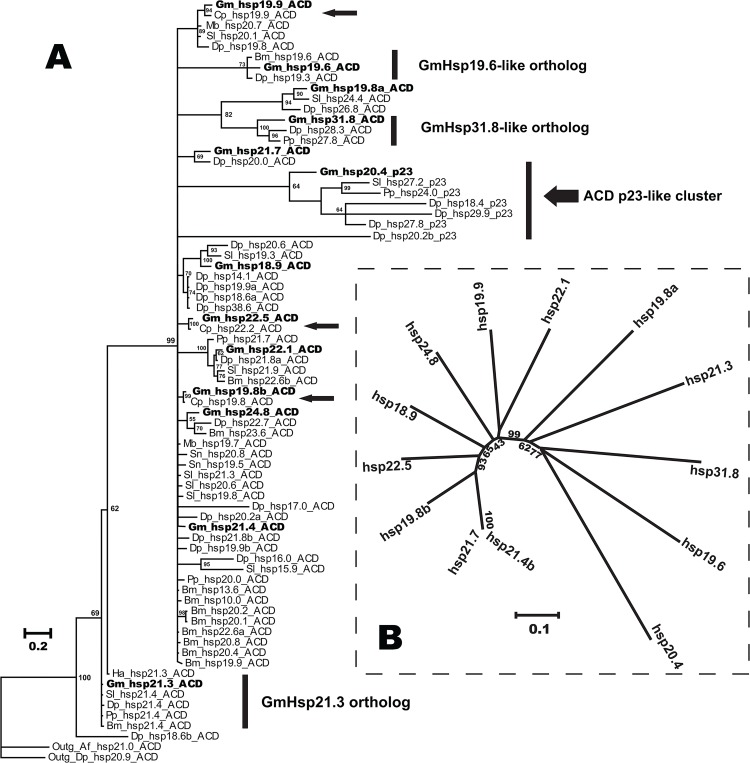
Phylogenetic trees of OFM sHsps.A. Phylogenetic tree of the lepidopteran sHsps. A total of 71 lepidopteran sHsps and two outgroup sequences were used in this Bayesian phylogenetic tree. Only the conserved a-crystalline domains were aligned and used for tree construction. Percentage bootstrap values above 50% were indicated on each cluster. B. An unrooted neighbor-joining tree was constructed with 13 sHsp amino acid sequences from G. molesta. Bootstrap supports of > 40% are shown on the nodes of the tree. The G. molesta sHsps are labeled in bold. Thin arrows indicated the close relationship between codling moth and OFM.